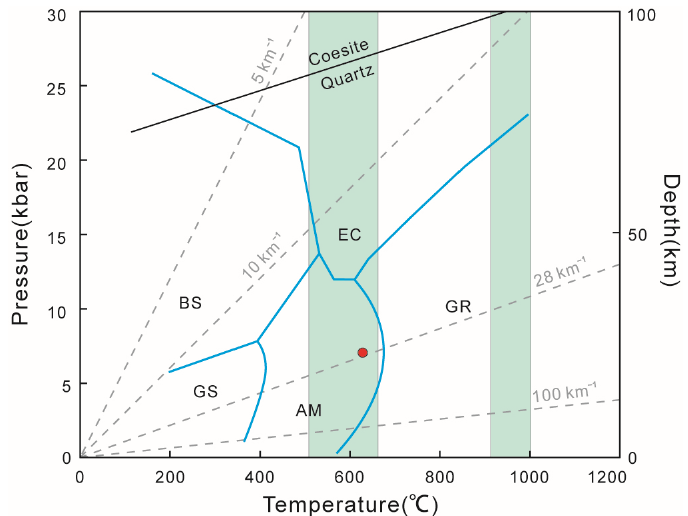
Figure 8. Pressure–temperature diagram. Reprinted with permission from ref. [40]. 2002 Wiley Online Library. The red circle represents an average value (630 ± 30 °C) of estimated crystallisation temperature for rutile from the Baishugang–Wujianfang district at a pressure of 7.0 kbar. Abbreviations of metamorphic facies: BS = blueschist-facies, GS = greenschist-facies, AM = amphibolite-facies, GR = granulite-facies, EC = eclogite-facies.